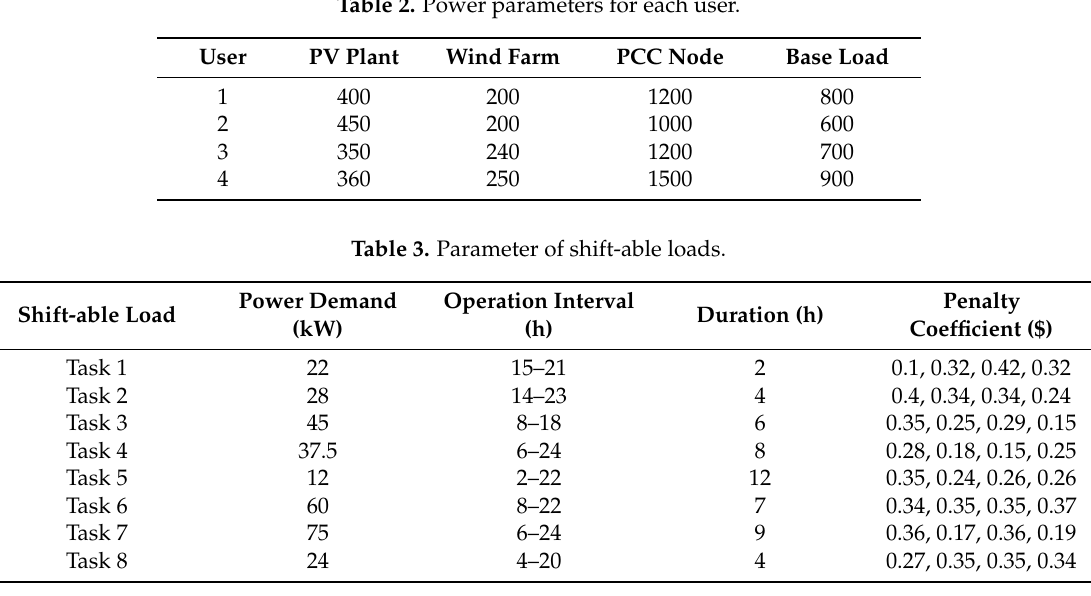
Table 2. Power parameters for each user.